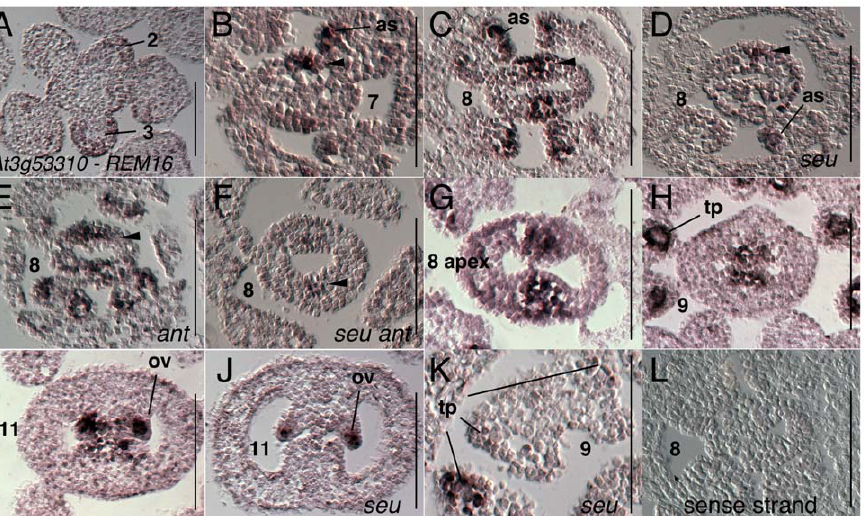
Figure 2. Results of insitu hybridization with At3g53310 ( REM16 ) antisense probe. Results of in situ hybridization with At3g53310 ( REM16 ) antisense probe (A–K) or with sense strand control probe (L). Numbers indicate floral stages. All panels show transverse (cross sectional) tissue orientation. Arrowheads indicate medial domain expression; ov - ovule; as, archesporial precursors; tp, tapetum. All scale bars are 100 microns. All panels are Col-0 wild type tissue unless otherwise indicated.